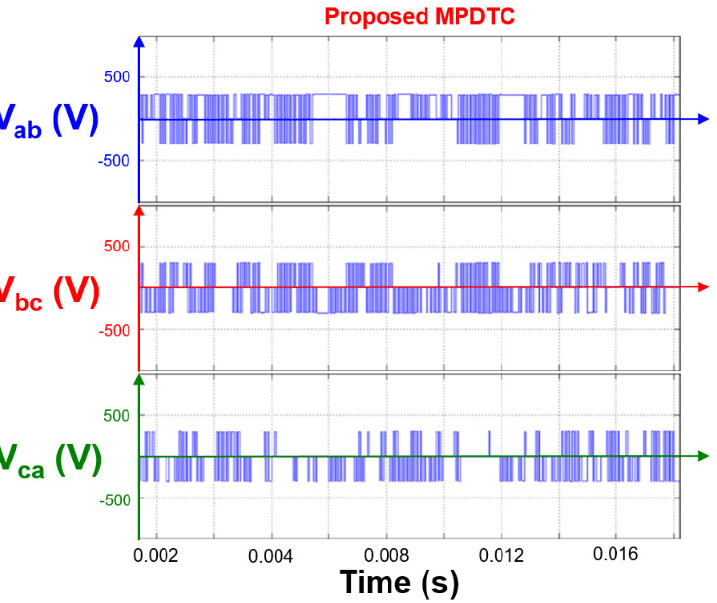
Figure 16. Simulated line voltages in U–V-, V–W-, and W–U-phases ( V ab , V bc , and V ca , respectively)